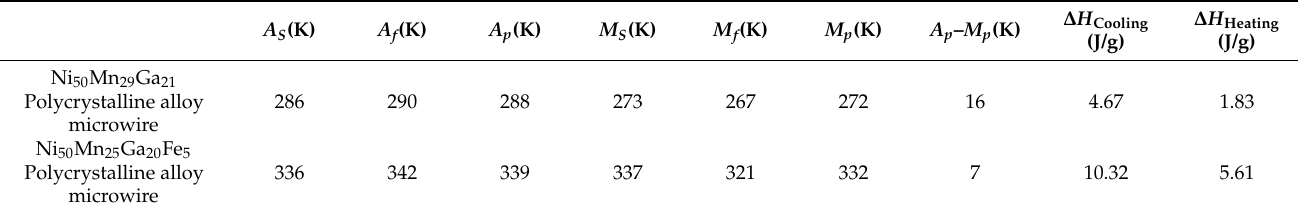
Table 2. Data measured by DSC differential calorimetry